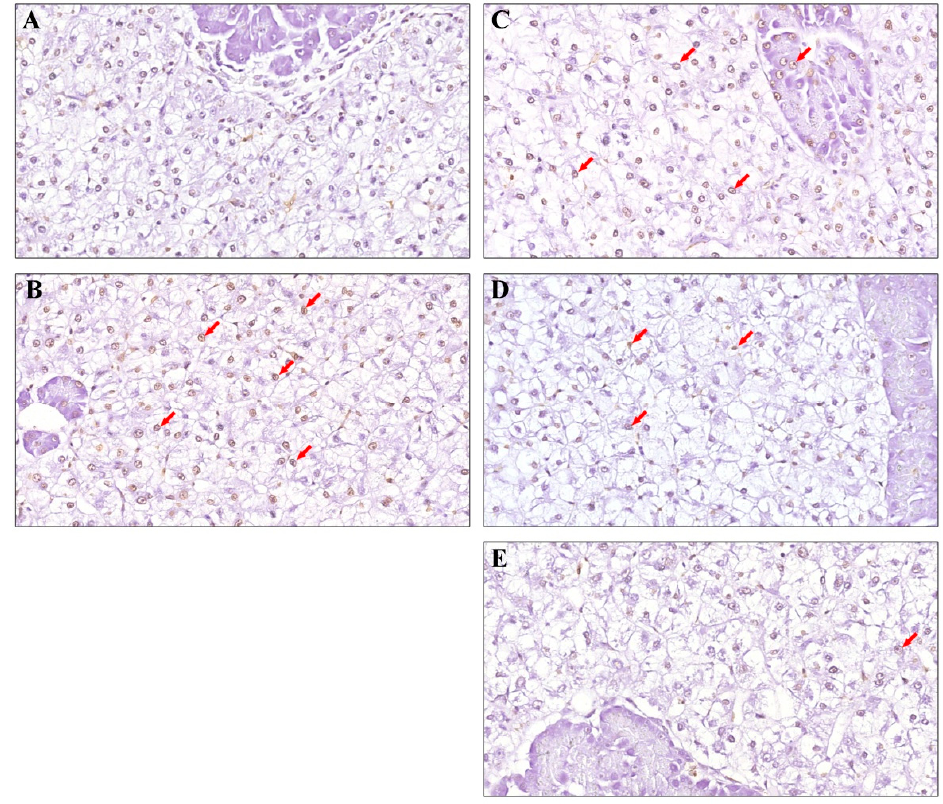
Figure 2. Effect of Sal B on apoptosis of hepatocytes of Nile tilapia. All sections were photographed